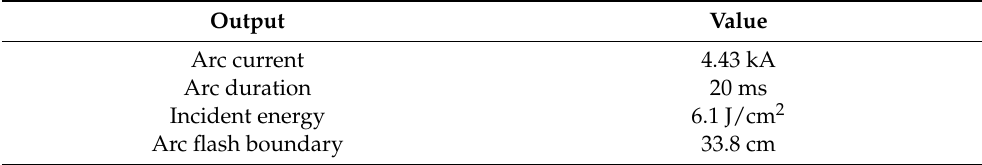
Table 7. ArcPro simulation results summary—Case study 3.